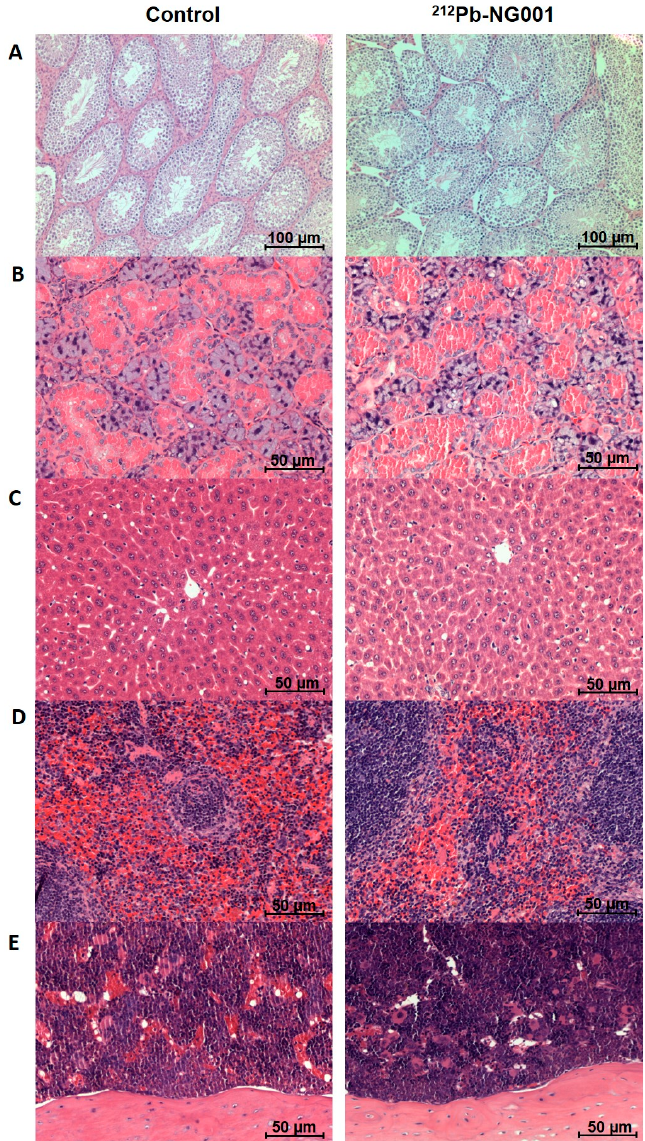
Figure 6. Representative histological images of testes (×10 magnification, ( A )), salivary glands (×20 magnification, ( B )), liver (×20 magnification, ( C )), spleen (×20 magnification, ( D )) and femur (×20 magnification, ( E )) of BALB/c mice 12 months after administration of saline (left) or 0.33 MBq of 212 Pb-NG001